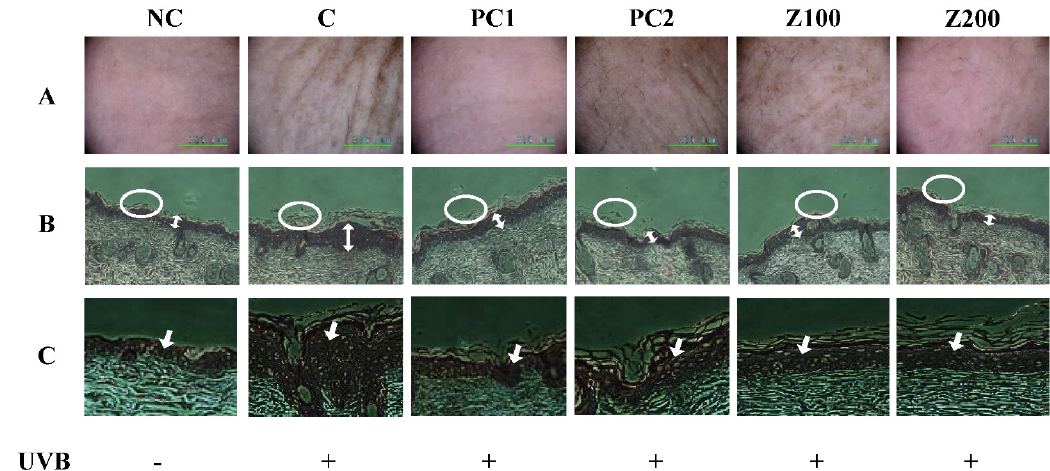
Figure 3. Effects of FSH-ZM on wrinkle suppression and skin thickening in skin from the back of UVB-irradiated HRM-2 hairless mice. ( A ) The wrinkle photography. ( B ) H&E staining. ( C ) Fontana–Masson staining. NC, normal control; C, UVB-irradiated control; PC1, positive control 1, L-ascorbic acid 200 mg/kg b.w.; PC2, positive control 2, Arbutin 200 mg/kg b.w.; Z100, FSH-ZM 100 mg/kg b.w.; Z200, FSH-ZM 200 mg/kg b.w.